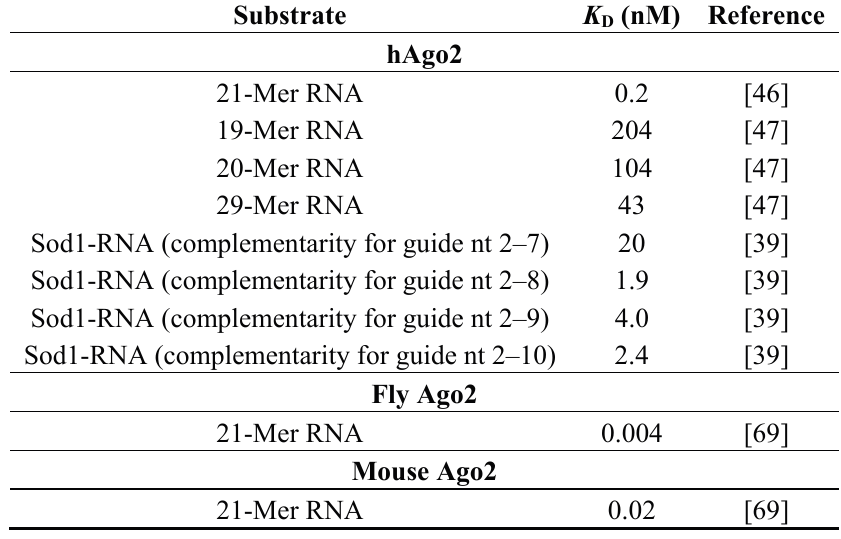
Table 4. Binding affinities of different Ago-guide binary complexes for various target